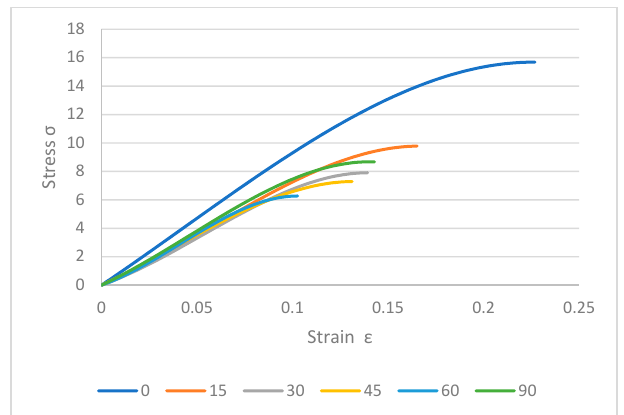
Figure 13. Stress–strain curves for flat samples.